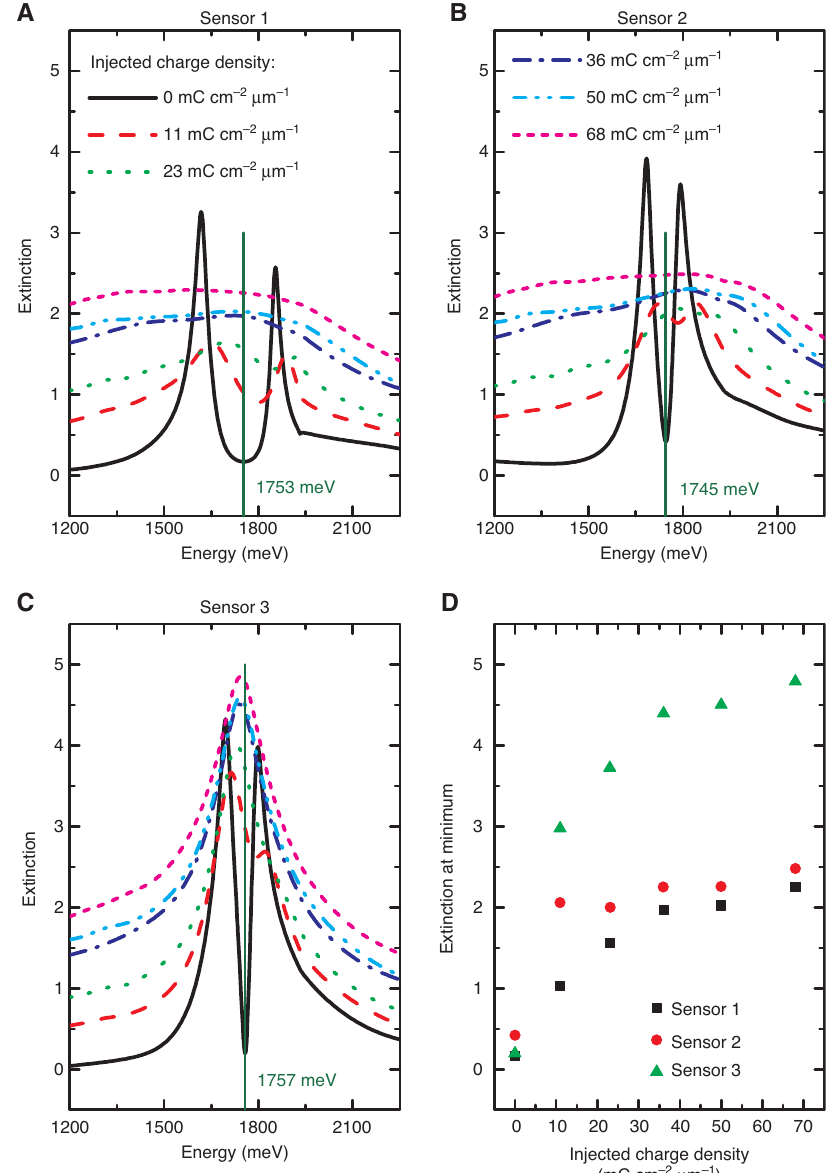
Figure 6: Performance of three different sensor designs. Calculated extinction spectra for different injected charge densities for (A) sensor design 1, (B) sensor design 2, (C) sensor design 3, and (D) Extinction values at the extinction minimum are plotted versus the injected charge density for the three sensor